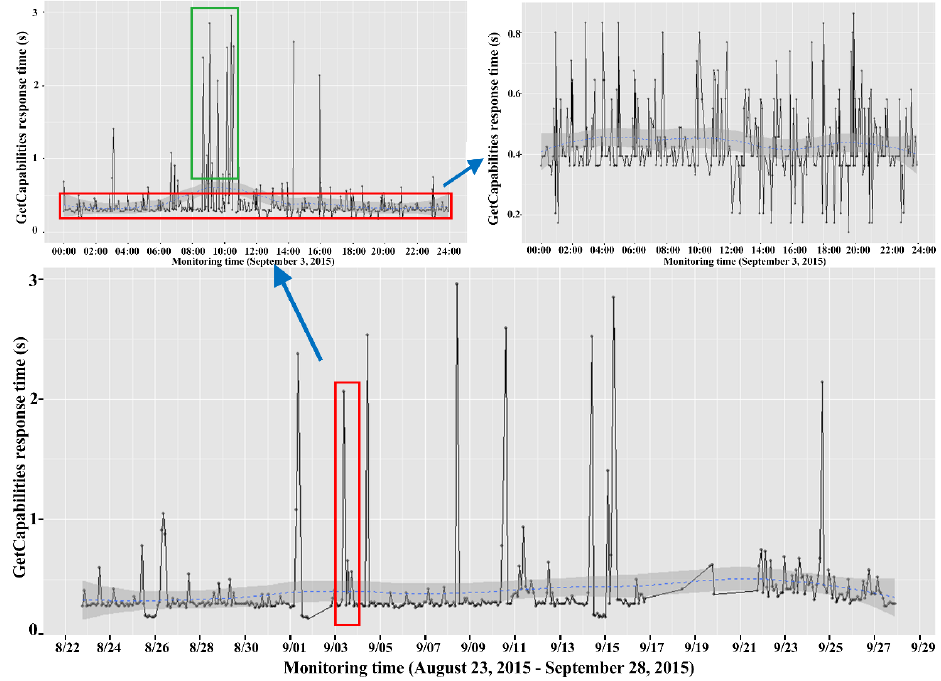
Figure 15. Time series characteristics of WMS response times.